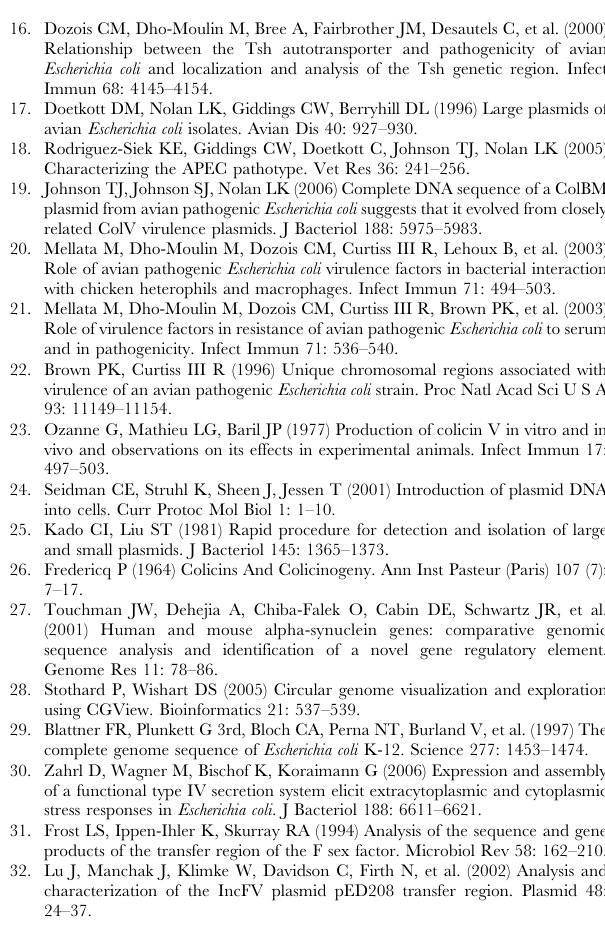
Figure S1 The genetic map of the replication and stability regions in pAPEC-1. This figure shows the genetic map of the replication and stability regions in pAPEC-1: The region of the stability containing the sopABC (A) and the second replicon repFIC region (B). Black arrows represent known ORFs genes, grey arrows represent truncated genes, white arrows represent hypothetical protein genes, and hatched arrows are Insertion Sequences genes.